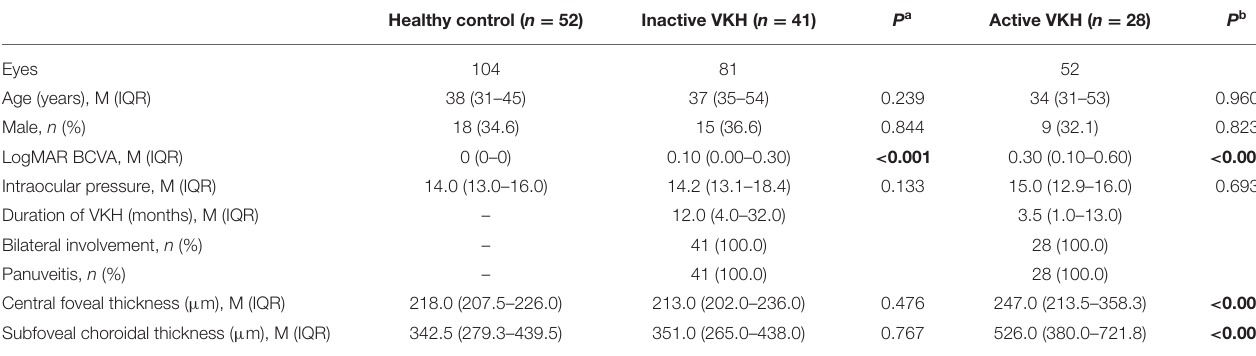
TABLE 1 | Demographic and clinical features of healthy controls and patients with inactive/active VKH.